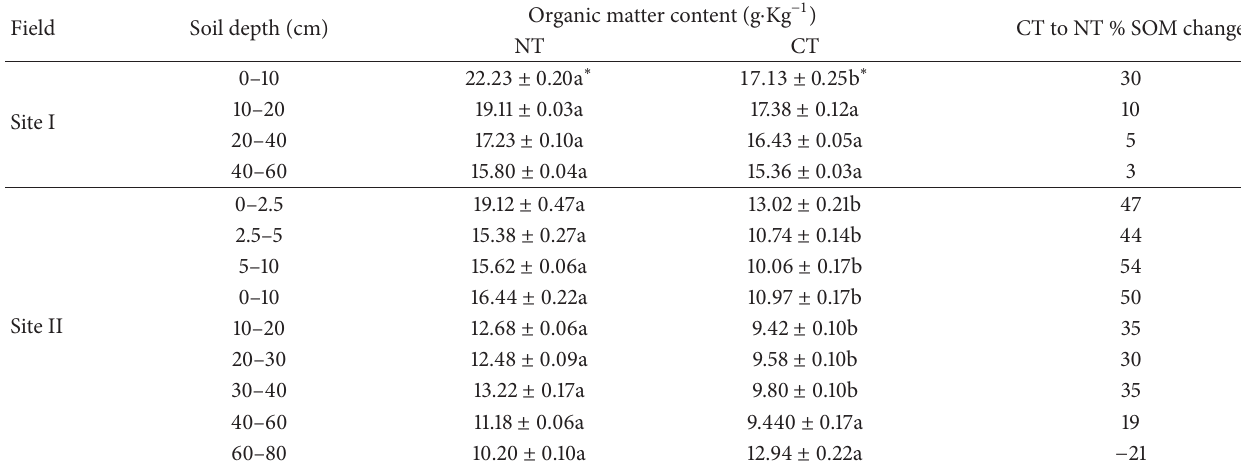
Table 3: Tillage effect on SOM content (mean ± standard